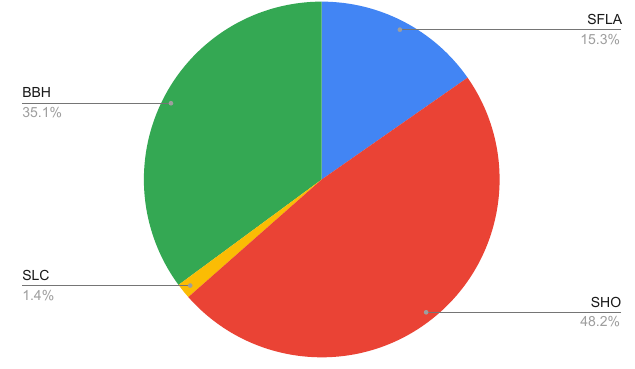
Figure 8. Algorithm selection